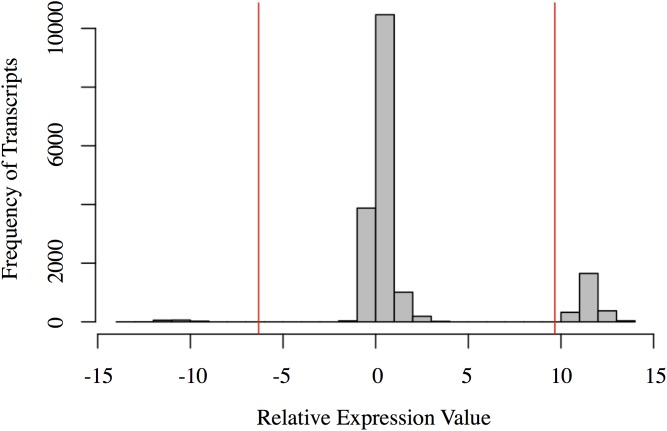
Histogram of the relative expression values for each transcript. Each bar represents the number of transcripts with a relative expression value within that range (x-axis). The red vertical lines represent two standard deviations below the mean (left) and above the mean (right). Transcripts to the left of the left red line are highly expressed in the other immune organs (spleen, bursa, and thymus). Transcripts to the right of the right red line are highly expressed in the Harderian gland. Figure generated in R.